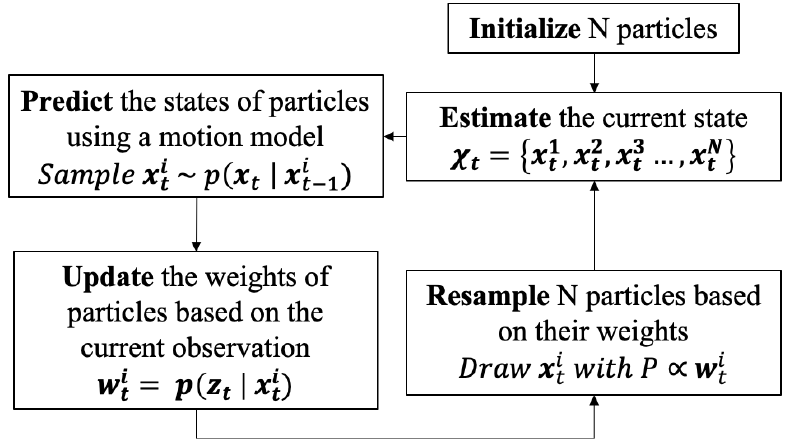
Figure 6. Diagram of a particle filter